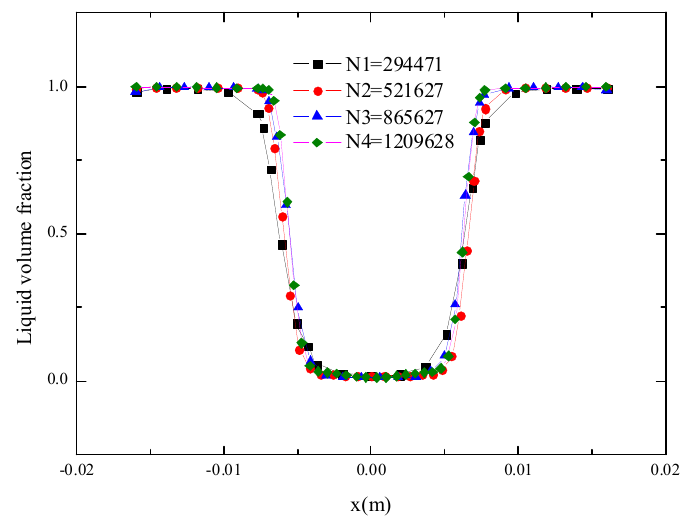
Figure 4. Liquid Volume Fraction Distributions with Different Number of Grids .